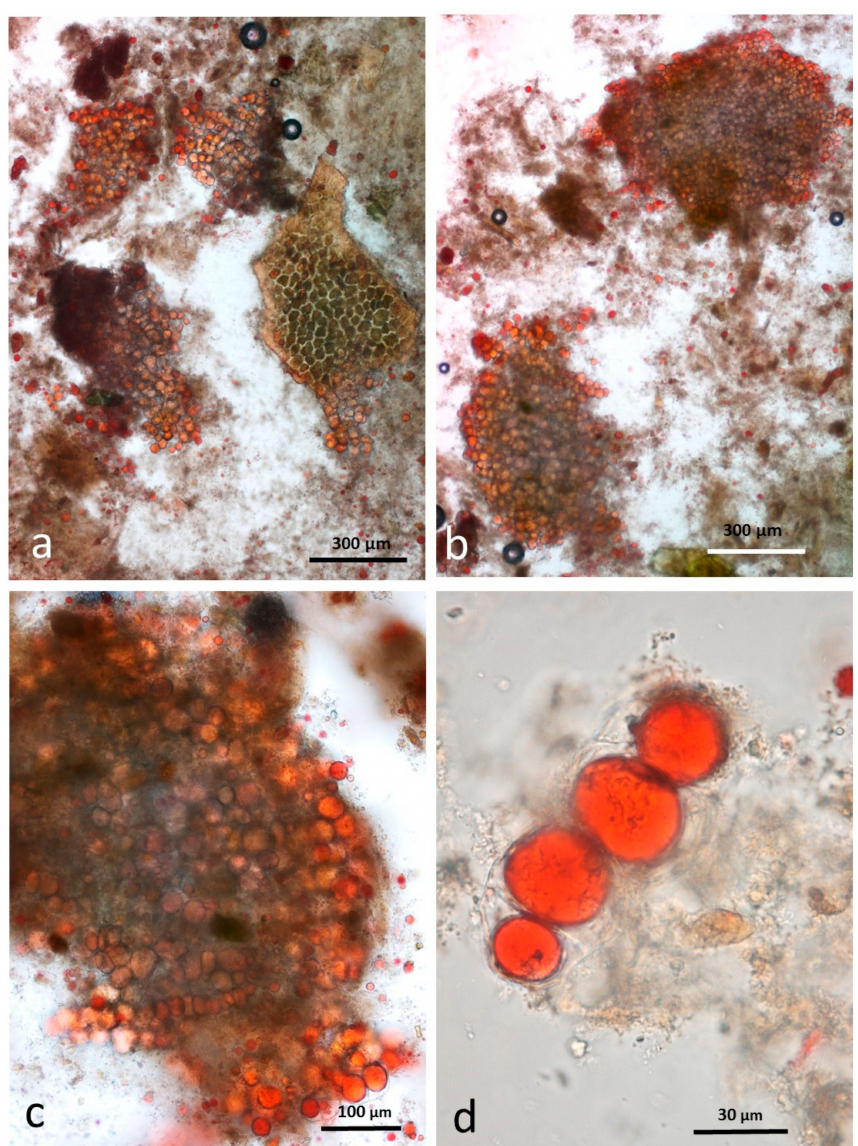
Figure 10. Faecal sample stained with Sudan IV from whole raw almonds diet ( a ) multicellular particles of almond tissue and aleurone cells (right) ( b ) almond particles but few free lipid drops ( c ) lipid in undamaged cells is coalesced ( d ) coalesced lipid confined by cell